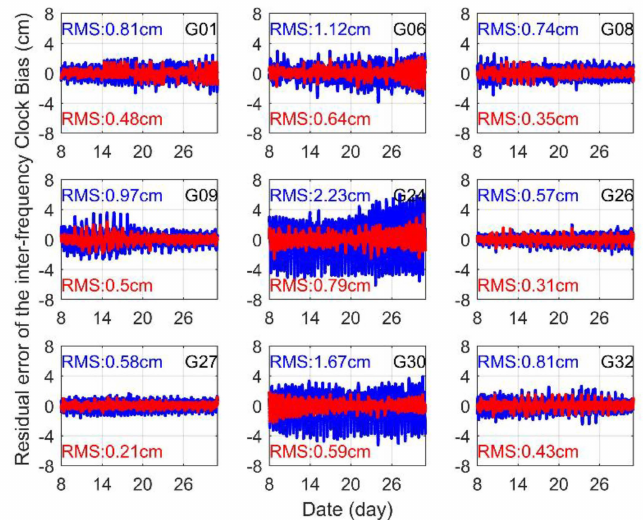
Figure 7. Prediction residual of the IFCB for GPS Block IIF satellites. The blue and red lines indicate unconsidered periodic variation and considered periodic variation,